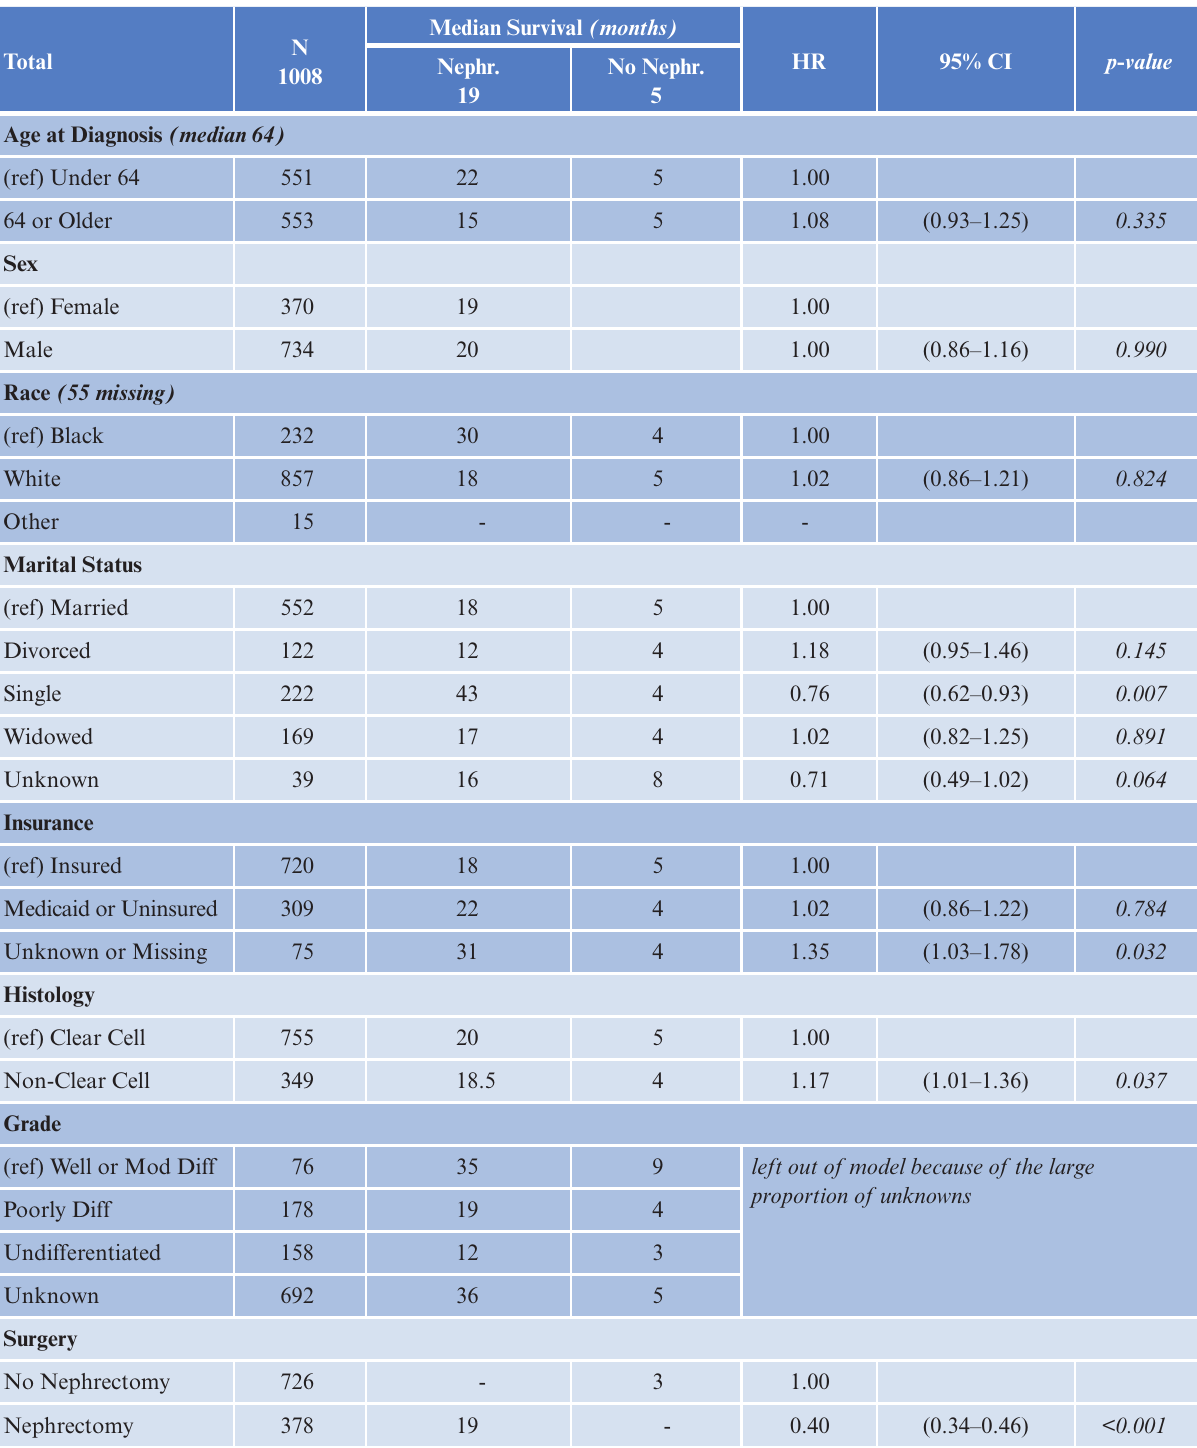
Table 5: Metropolitan Detroit Distant Stage Kidney Cancer: 2000–2013 Survival Analysis by Nephrectomy Status for Demo- graphic Characteristics and